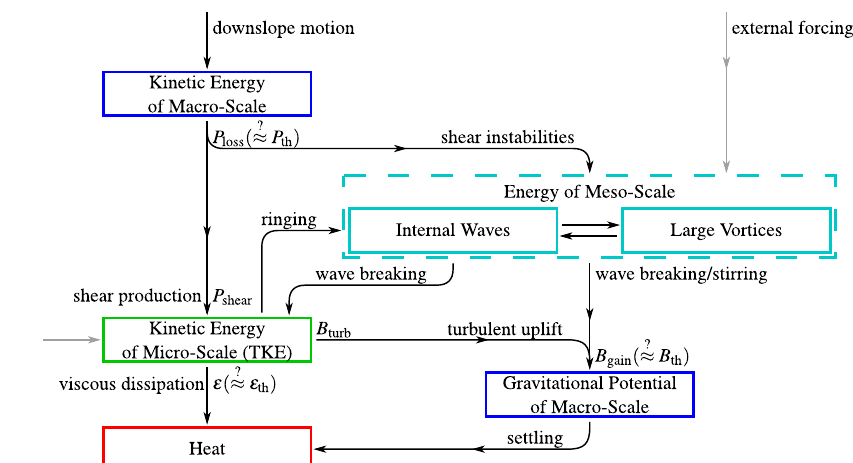
Fig. 6 | Proposed internal energetics of gravity currents. The internal stores of energy are shown by boxes, and the transfer of energy by black arrows: the energy lost at the tail of each arrow is equal to the energy gained at its tip. Grey arrows